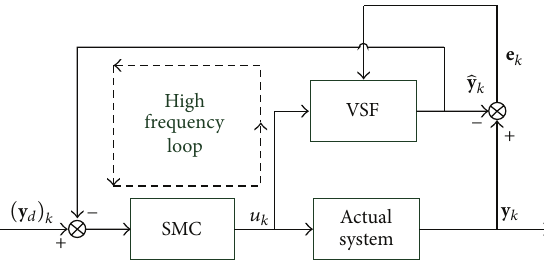
Figure 2: Overall structure of the sliding mode control based on variable structure